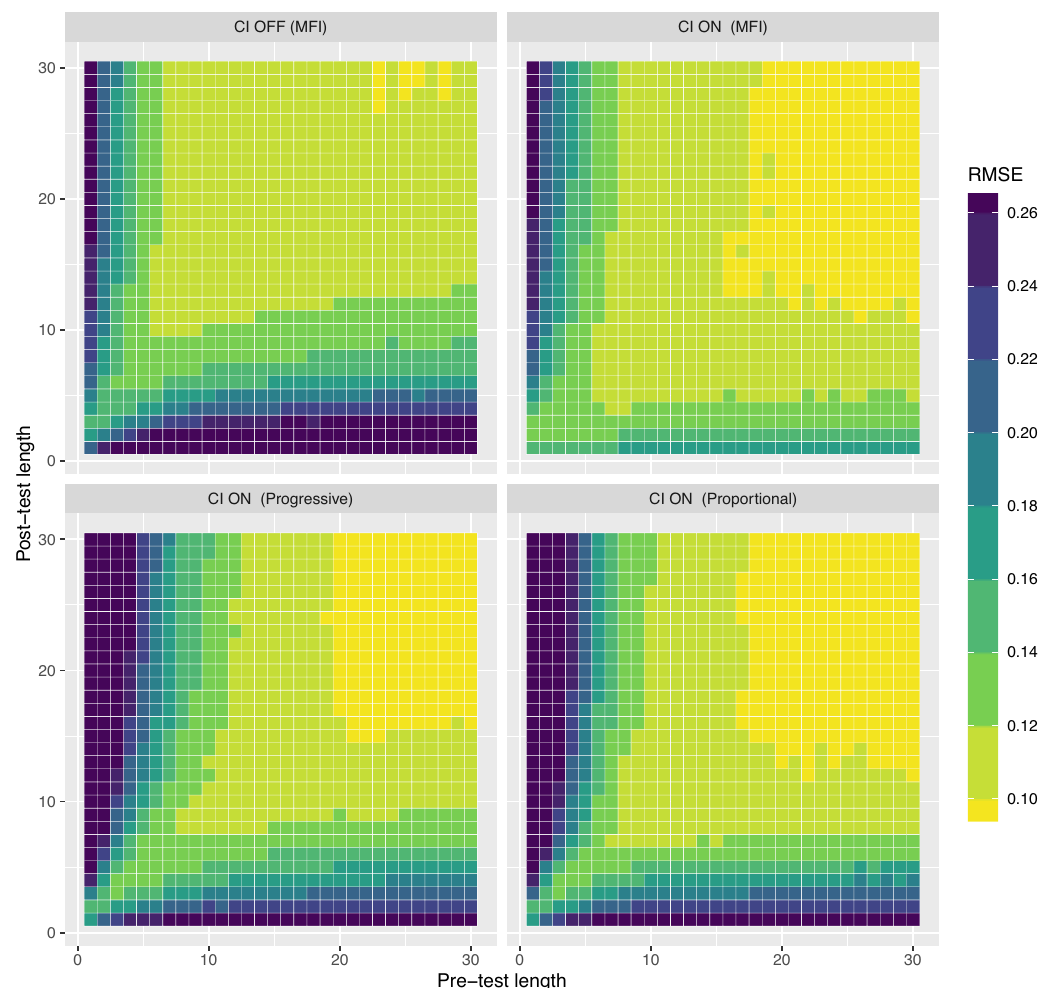
FIG. 3. Comparison of the effects of collateral information on RMSE for each test security algorithm (maximum Fisher information, progressive, and proportional). The x ( y ) axis is the pre- (post-) test length. The class size is 40. The results show the case with content balancing. The light (dark) color indicates a low (high) value of RMSE, the bin width of the RMSE is set to 0.02 (except for the highest bin, where RMSE > 0 . 26 ).